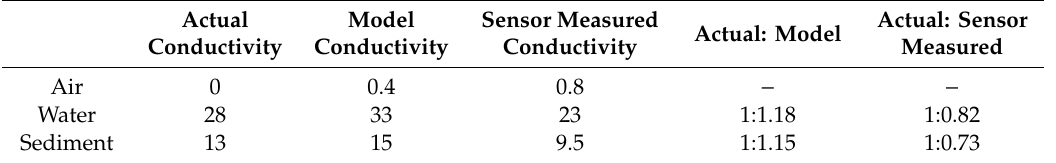
Table 5. Model and sensor measured gradient. The actual conductivity is measured by electrical conductivity meter.